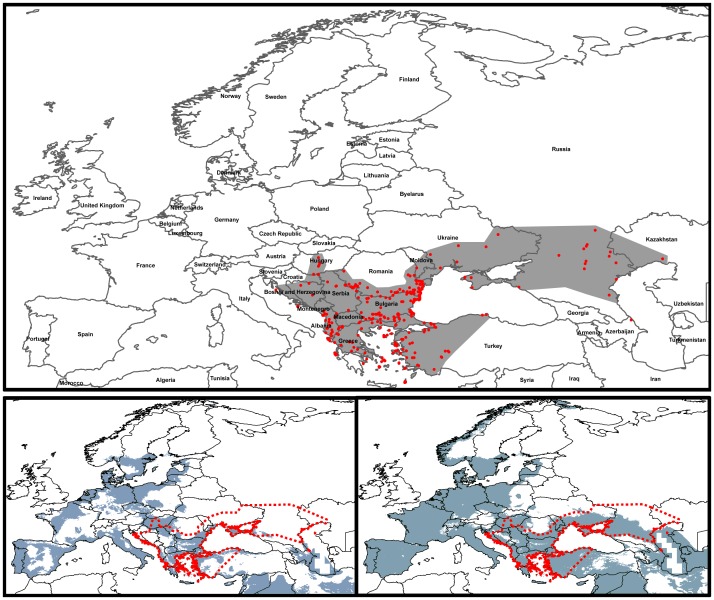
Present-day ecological niche models (green) for D. caspius (lower left - model generated by Maxent; lower right - model generated by GARP) in comparison to its known distribution range (upper panel, area in grey) (adapted after [66]) and presence records (red points).The red dotted line in lower panels corresponds to the grey area in upper panel (known distribution range).